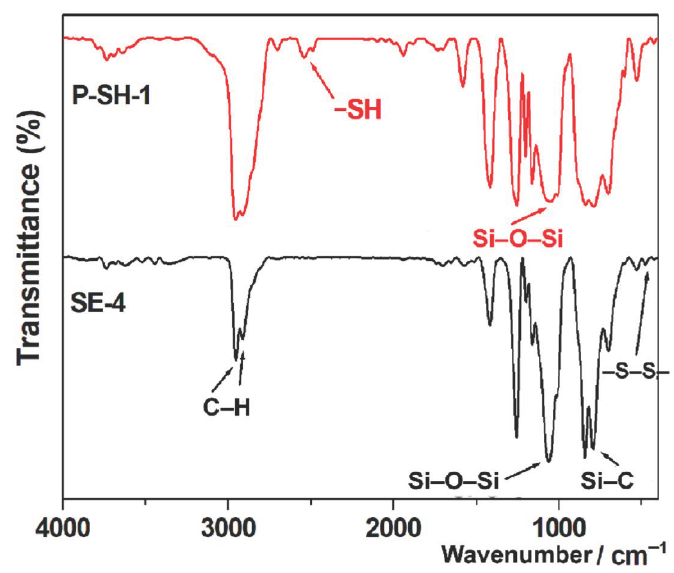
Figure 1. FT-IR of P-SH-1 and SE-4.